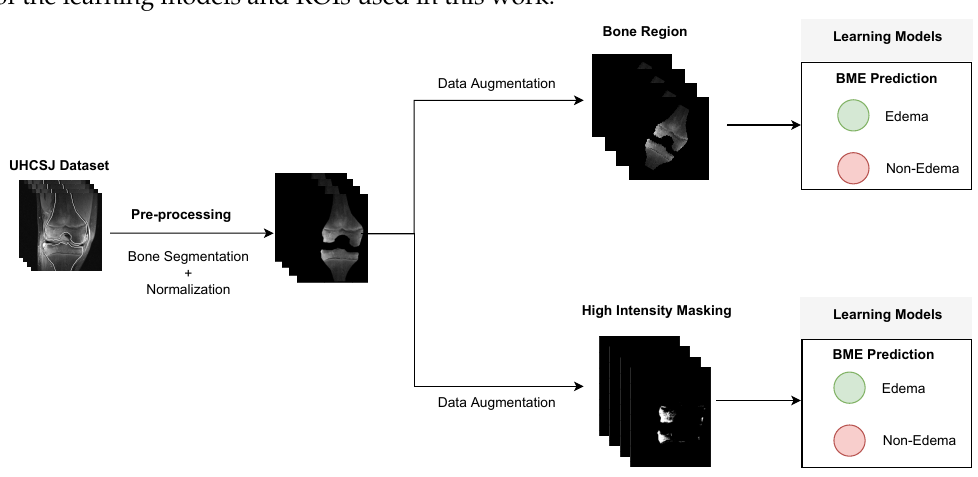
Figure 3. General overview of the developed pipeline for bone edema prediction in fluid-sensitive sequences based on two different strategies for input image